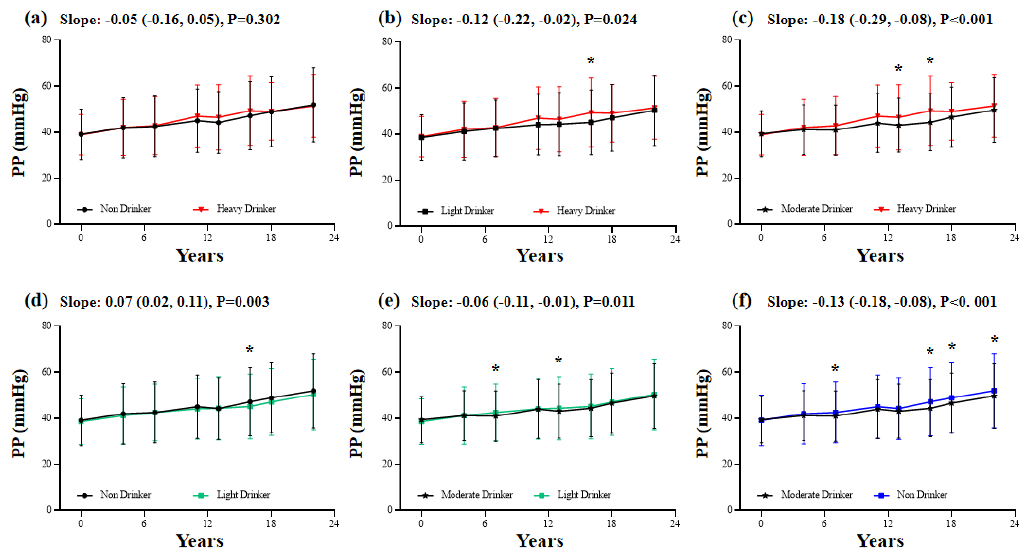
Figure 3. The association between alcohol consumption and change in systolic blood pressure. The multivariate-adjusted generalized linear mixed-effects models were adjusted for age, sex, marital status, education, residence area, smoking status, mean BMI, and mean waist circumference. The first group with a black color at each panel was the reference group. p -value < 0.017 was considered statistically significant for the multiple comparisons. * Blood pressure was significantly different between groups.